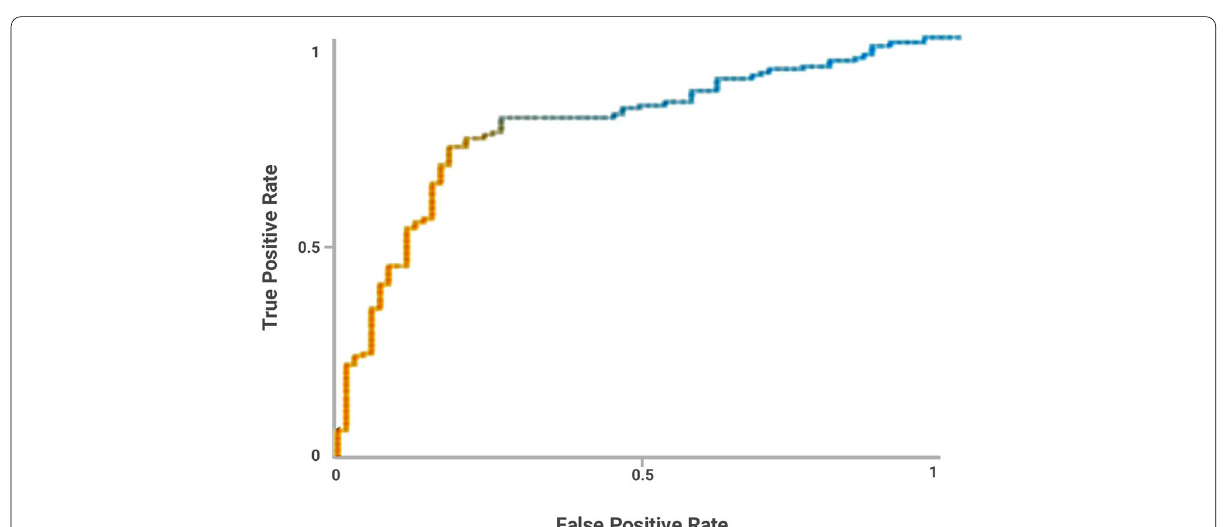
Fig. 6 ROC curve of Velocity